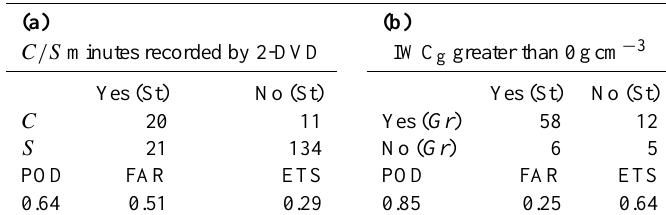
Table 6. Contingency tables between the presence of strokes (St) that occurred over the Sapienza site (within 10km radius in 1min) and convective or stratiform ( C/S ) minutes recorded by 2-DVD (a) , and IWC g greater than 0gcm − 3 as estimated by Polar 55C over the Sapienza site ( Gr ) (b) .